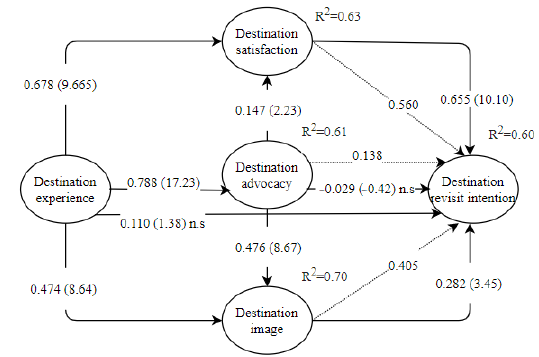
Figure 2. Structural